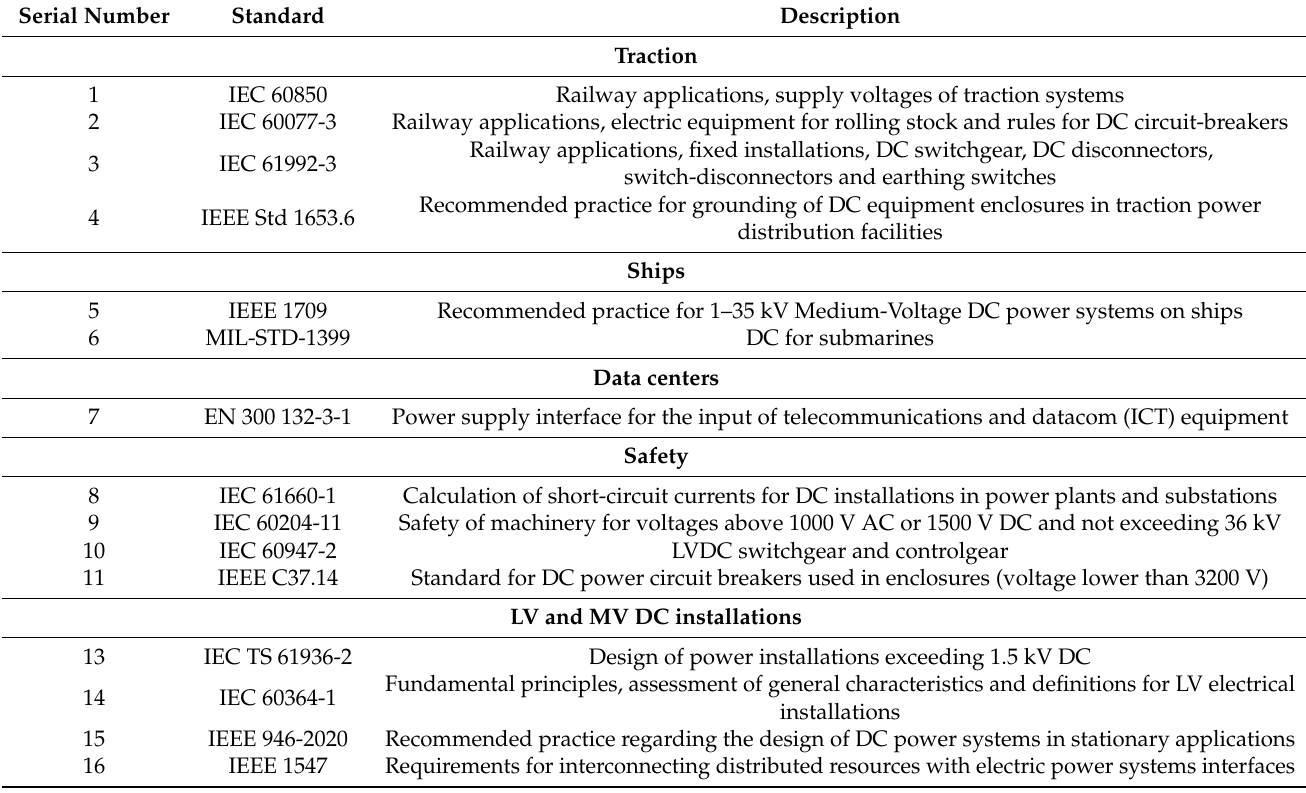
Table 6. Current standards addressing DC MGs (Data from